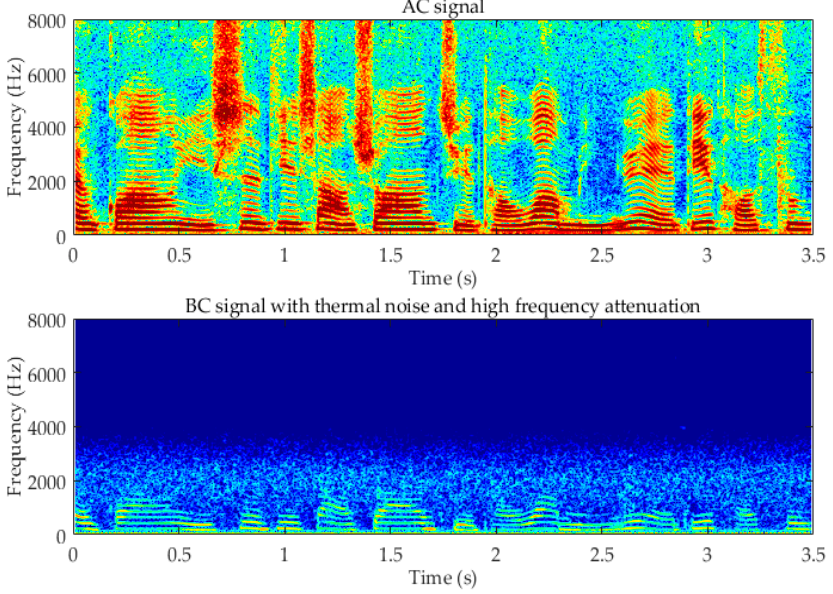
Figure 2. Clean air-conduction (AC) signal and bone-conduction (BC) signal.